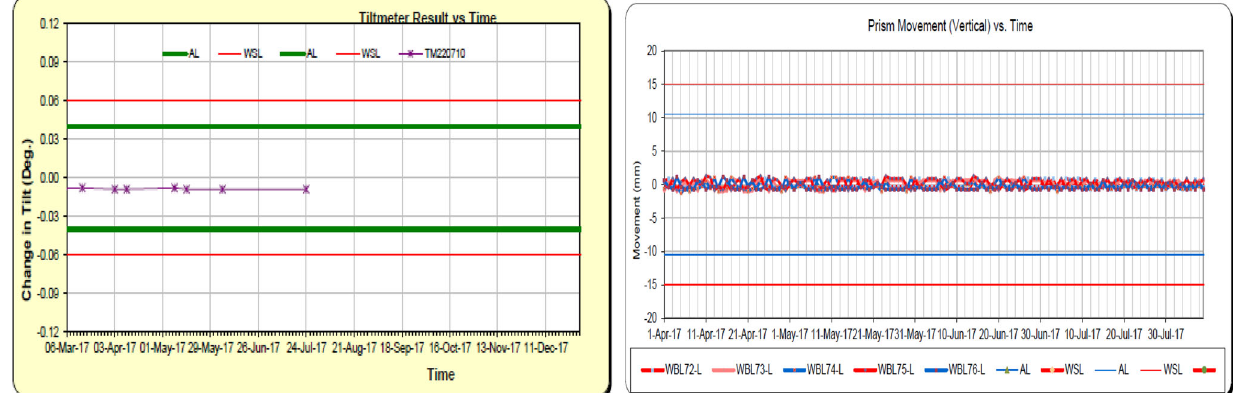
Fig. 13 Trend of tilt meter in the EWL station (left) and real-time prism movement in the EWL track way